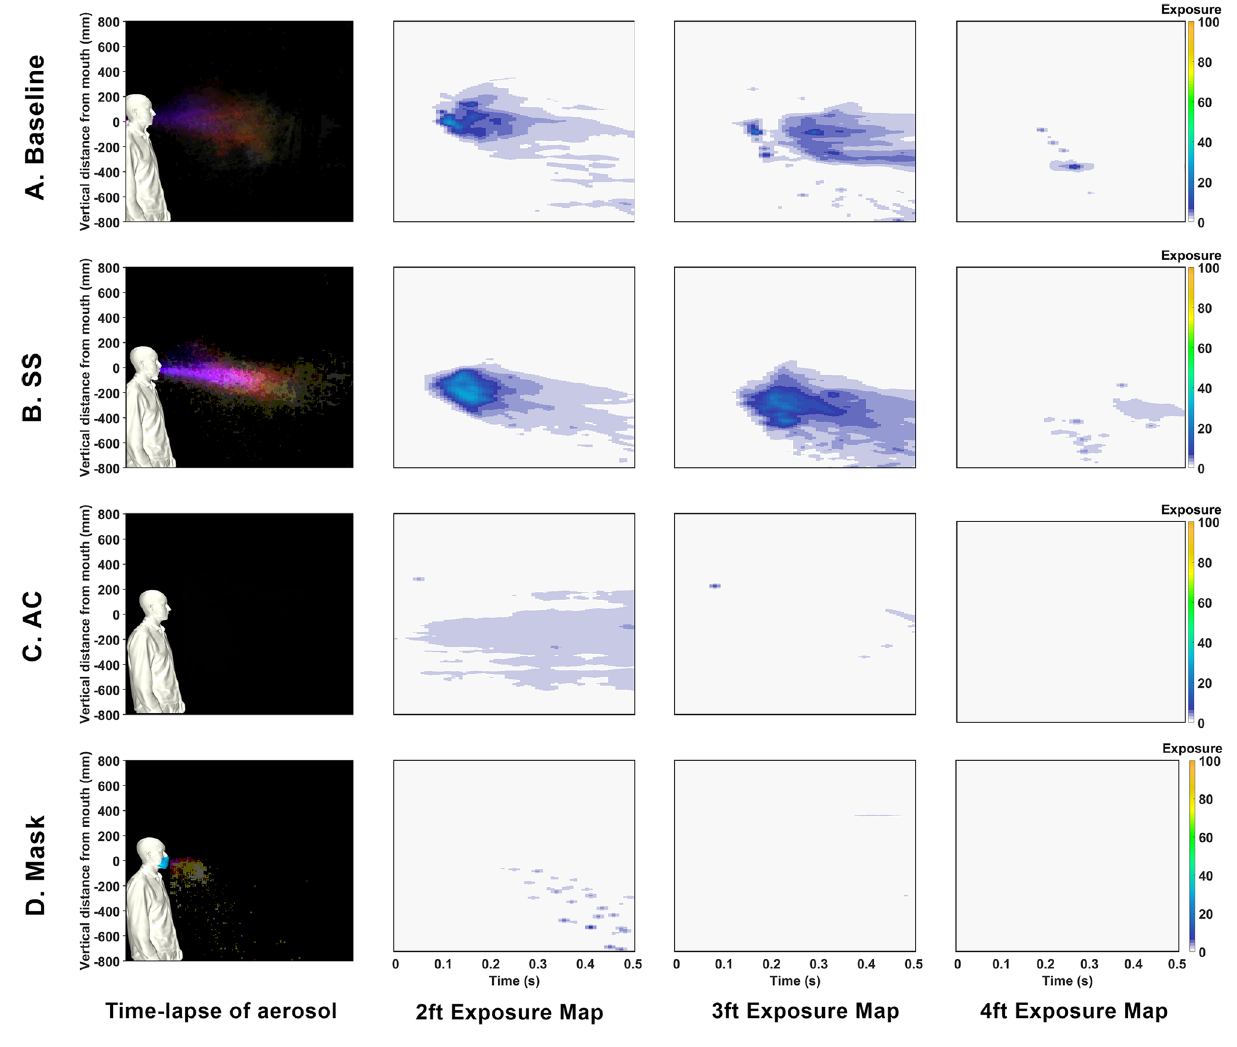
Figure 6. Summary of aerosol exposure from Human Sneeze with various saliva content modifiers. Column 1 is a time-lapse colored by time. Column 2–4 indicate exposure levels at 0.61 m (2 ft), 0.914 m (3 ft), and 1.219 (4 ft), respectively. Cases compare ( a ) baseline saliva, ( b ) SS, ( c ) AC, and ( d ) mask.